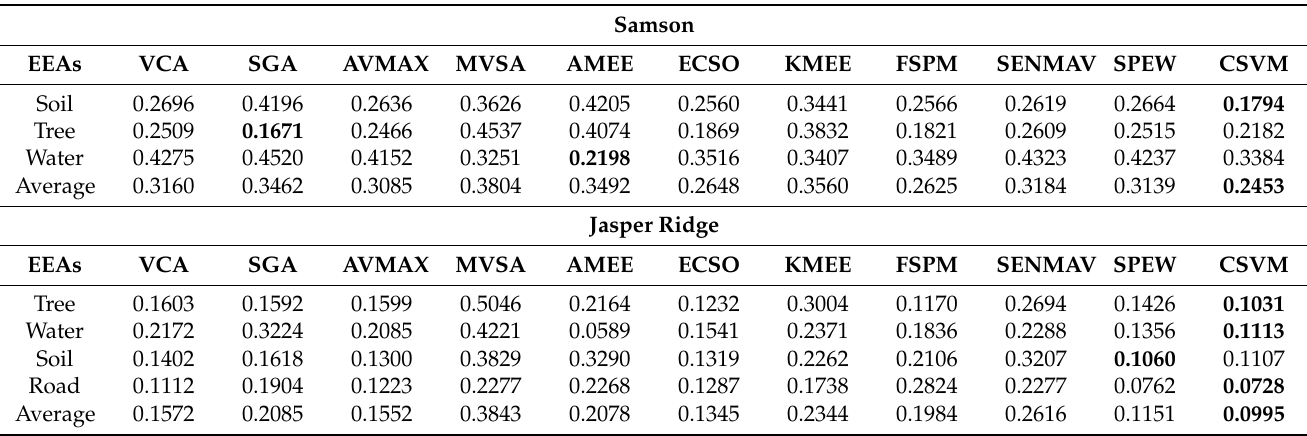
Table 2. RMSE of all test algorithms on Samson and Jasper Ridge datasets.